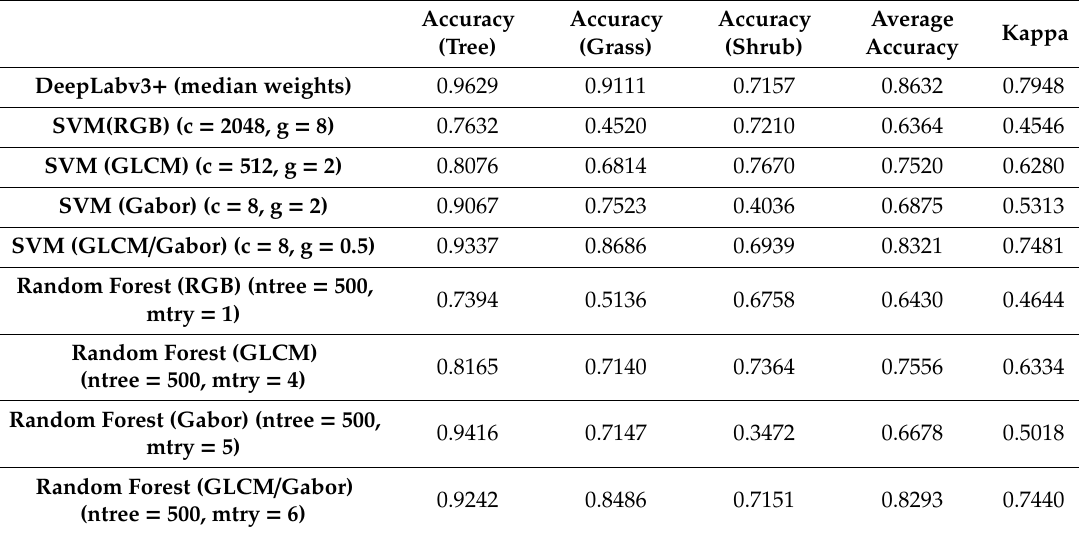
Table 24. Accuracy and kappa values for sampled pixels investigation in Oregon dataset.